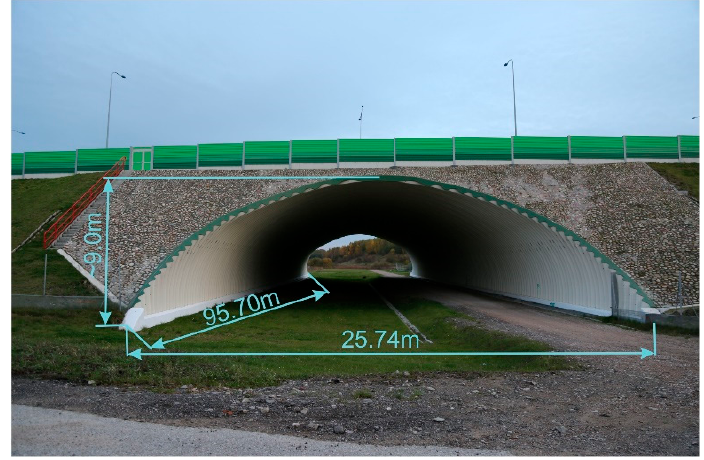
Figure 1. Soil-steel bridge side-view taken in October 2019.